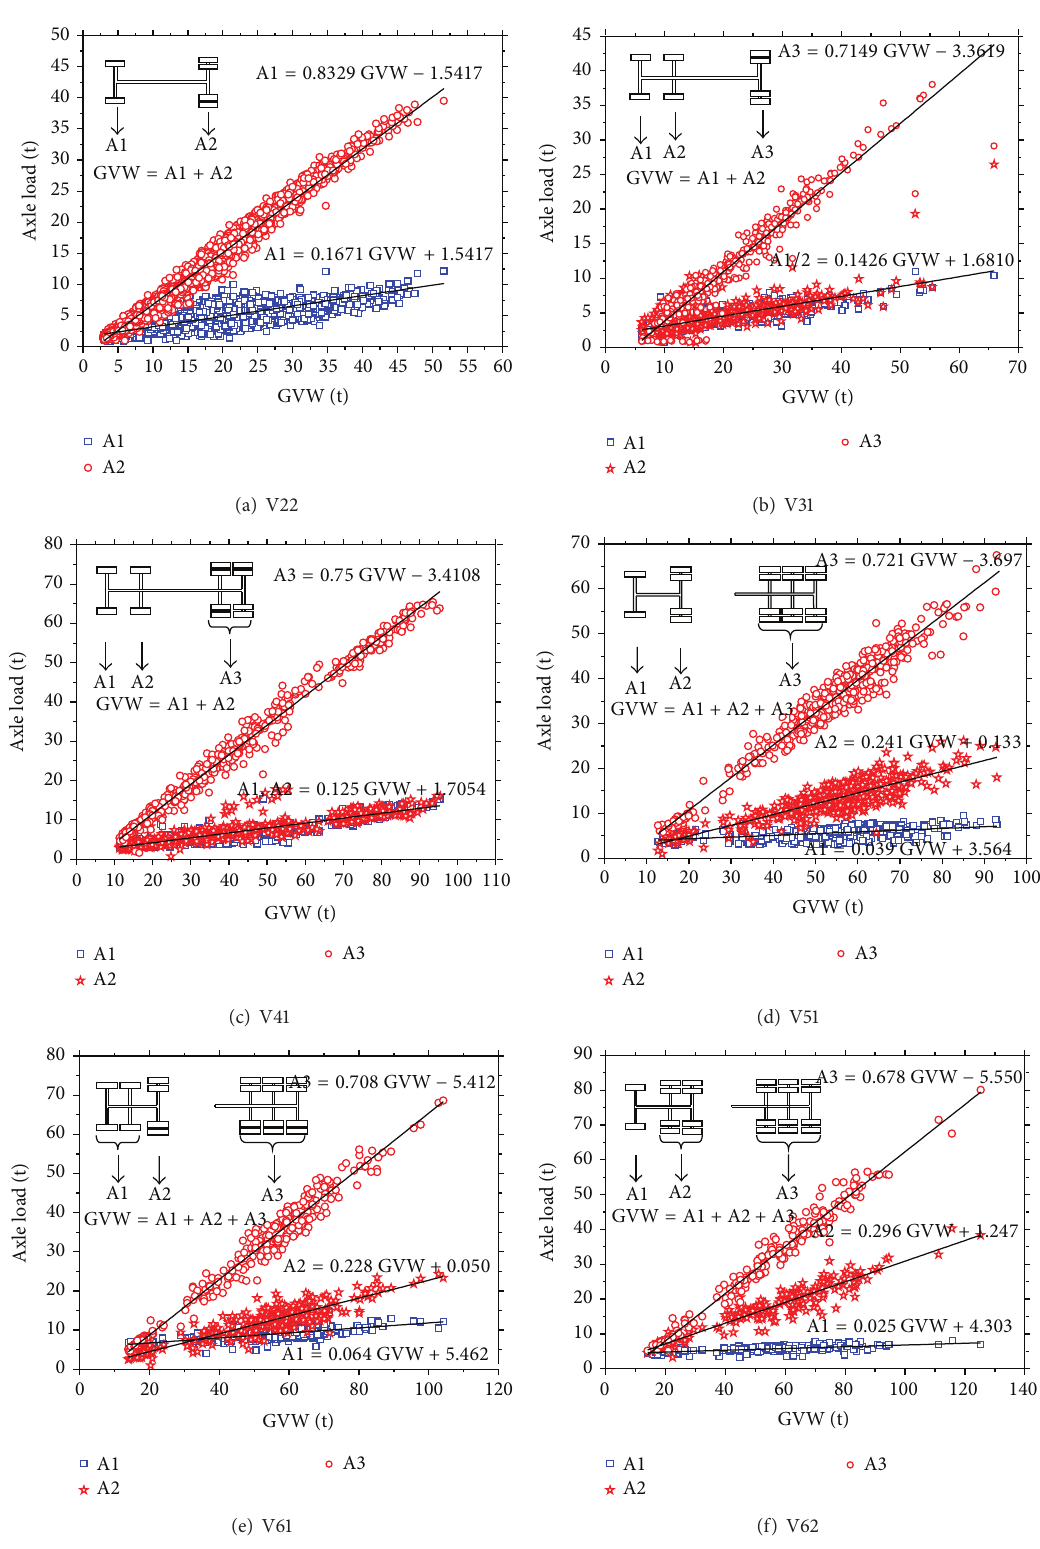
Figure 7: Relationships between GVW and axle weights of various vehicle